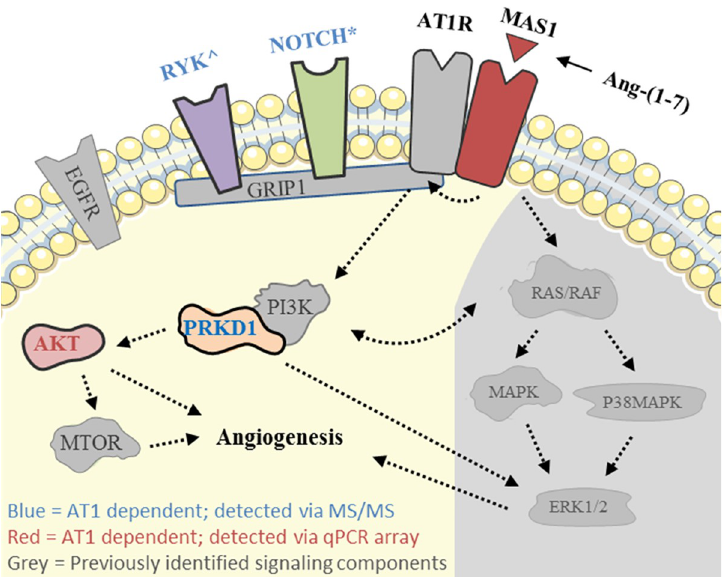
Fig 6. Diagram of suggested AT1 A dependent components of the Ang1-7/Mas signaling complex. Unless otherwise noted, molecules represented here were previously identified as components of the Ang-(1–7)/Mas1 signaling complex. Colored molecules represent AT1R A dependent components detected in the current study via mass spectrometry-based proteomics (blue label) and/or qPCR (red label). � Peptides mapped to NOTCH were not unique to specific NOTCH family members. ^RYK was not detected in our previous study but was included here due to known links to angiogenesis.